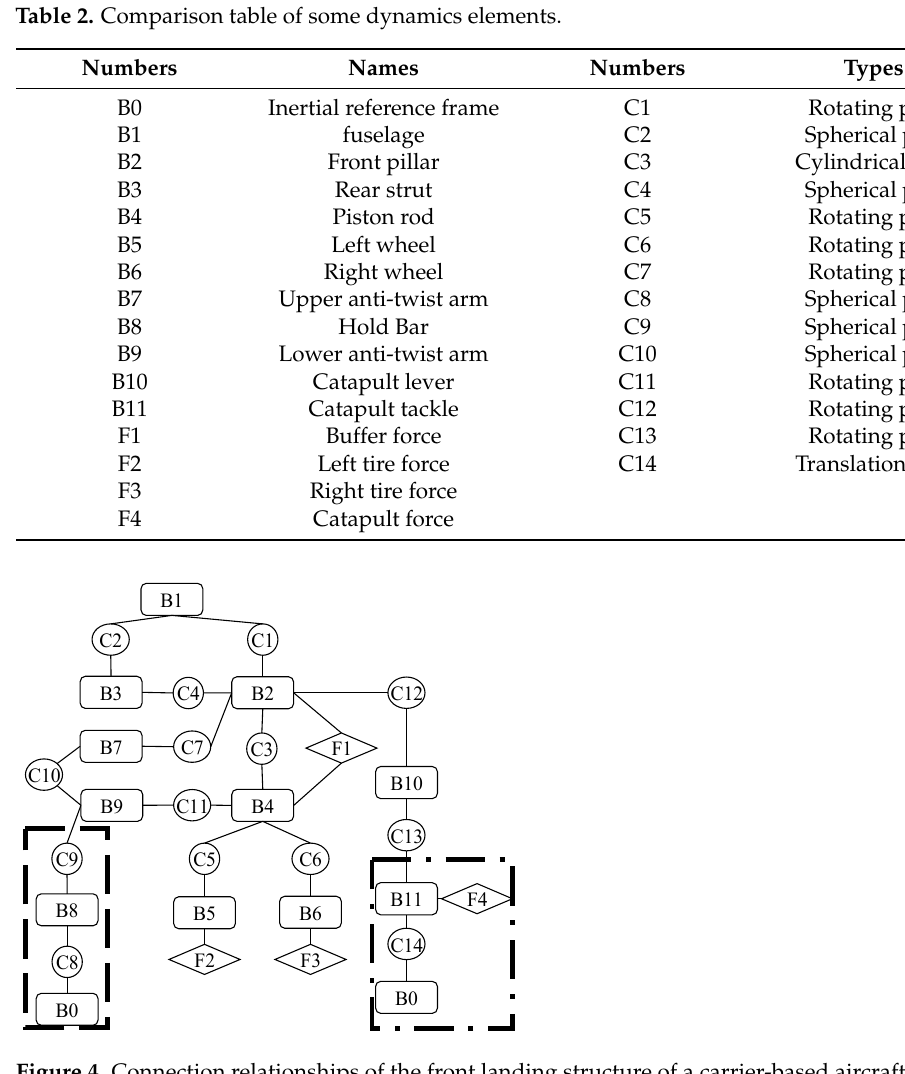
Figure 3. Carrier-based aircraft in the free-rolling phase.